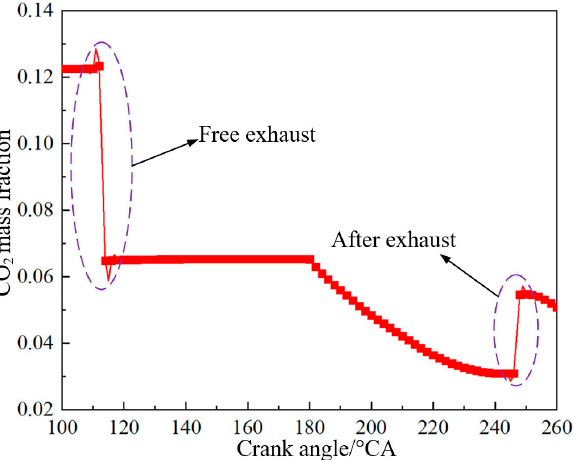
Figure 13. Variation of CO 2 Mass Fraction with Crankshaft Angle in Scavenging Process.